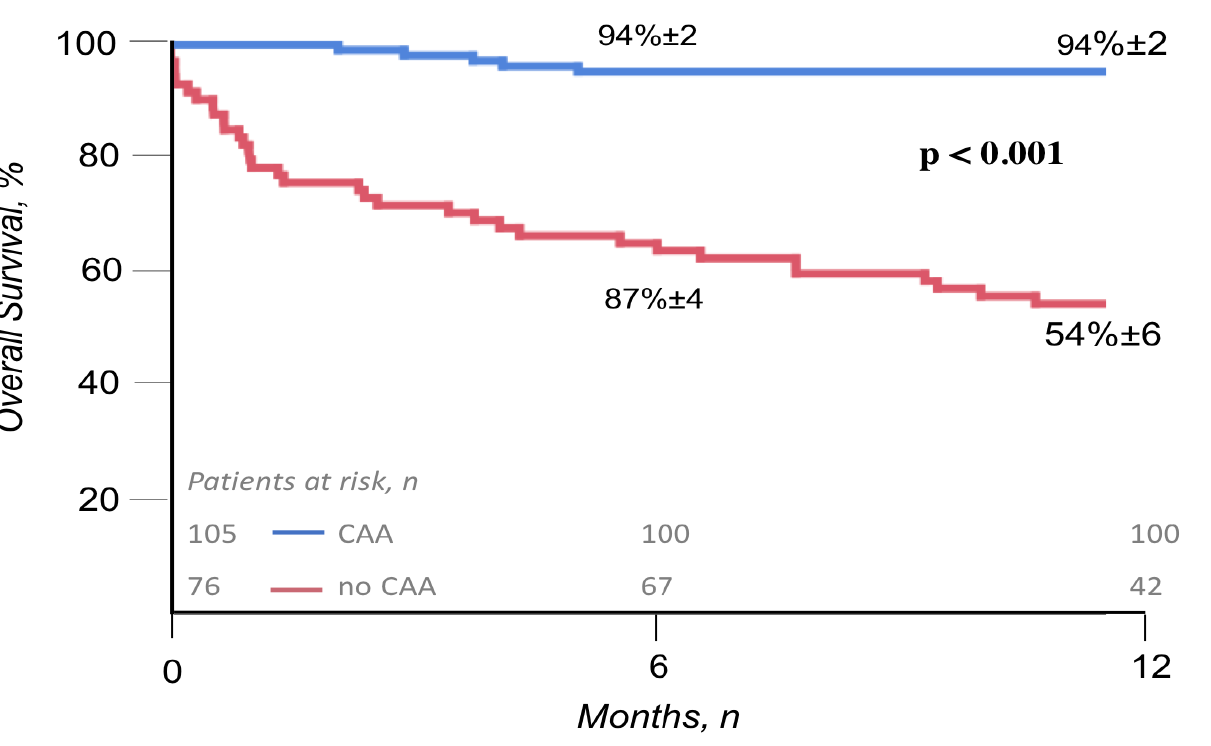
Figure 3. Overall 1-year survival after NSTEACS in patients treated with invasive strategy (blue line) and conservative strategy (red line). Figure legend: CAA (coronary artery angiography). and conservative strategy (red line). Figure legend: CAA (coronary artery